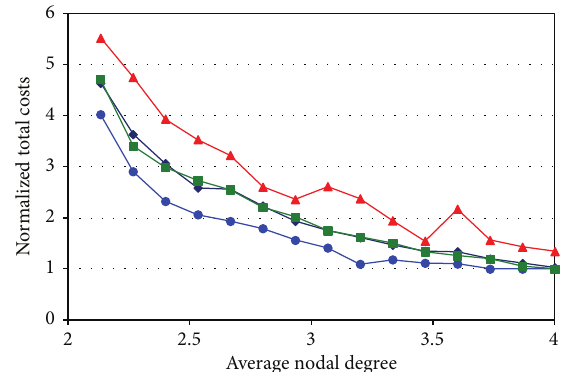
Figure 6: Normalized path restoration JCA total capacity costs.